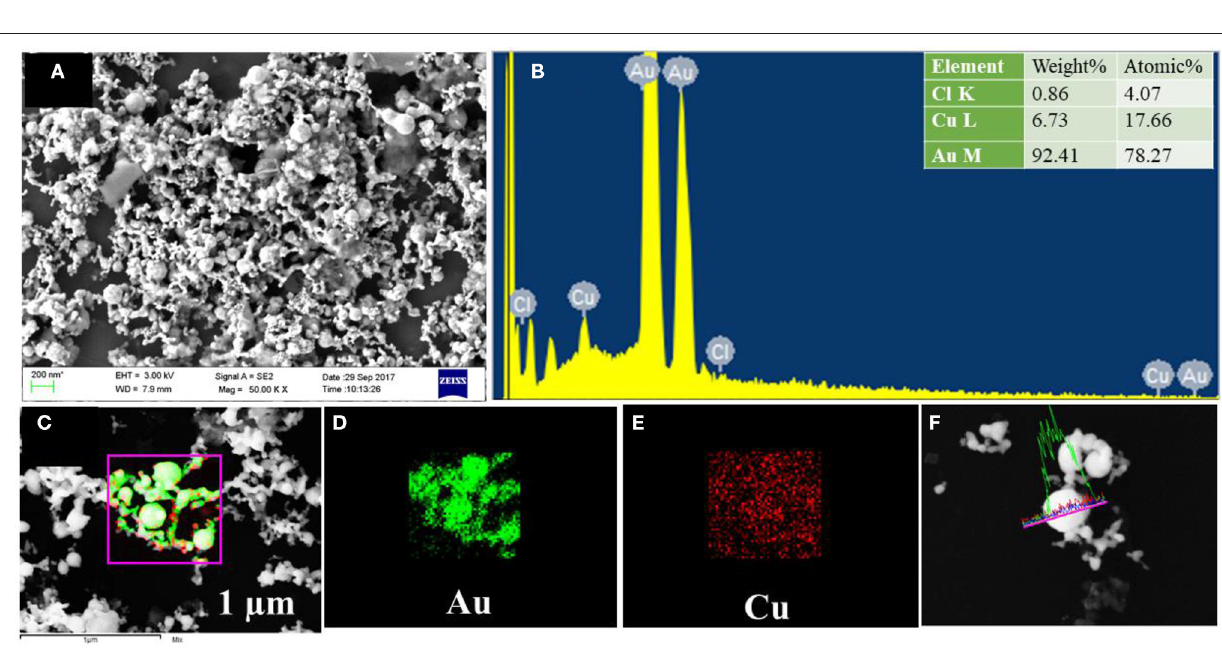
Frontiers in Physics |